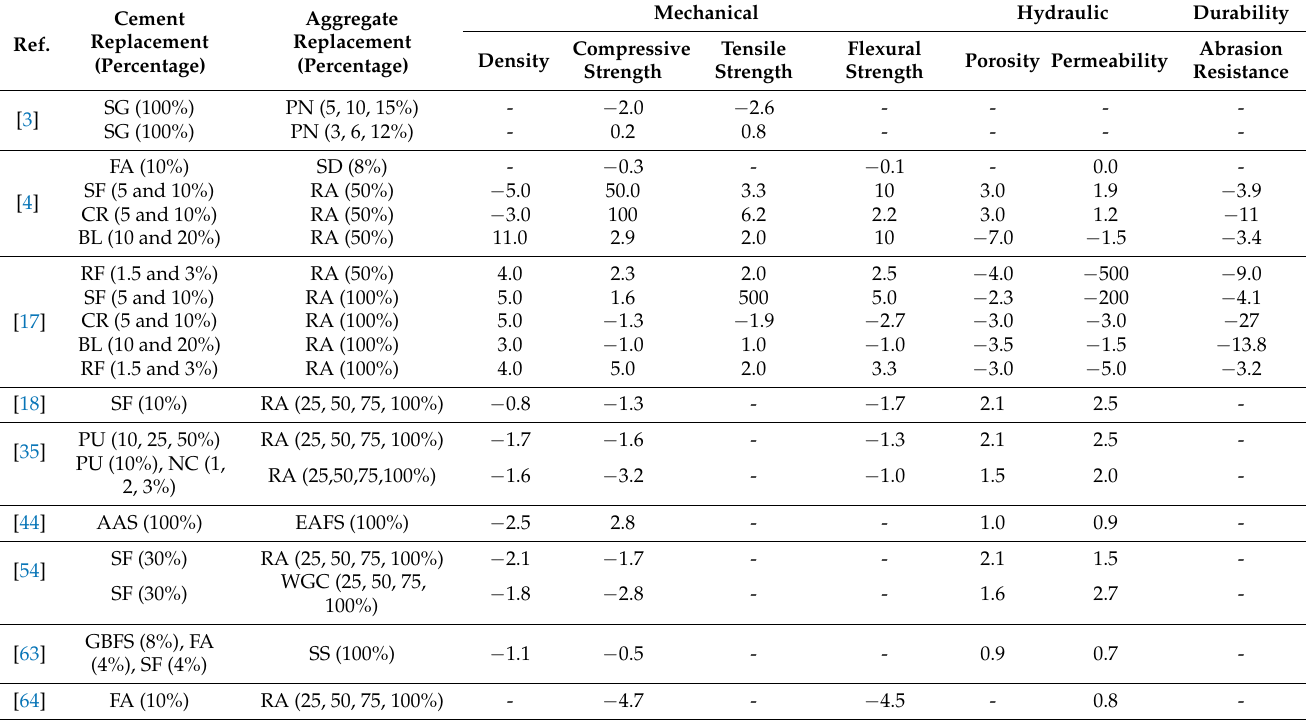
Table 3. Effect size for PC performance based on combined